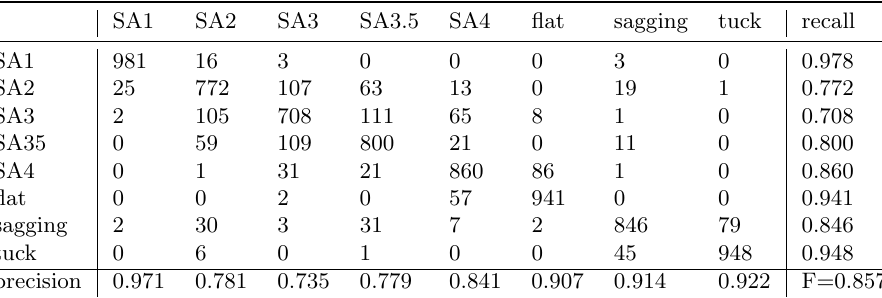
Table 5. Confusion matrix of detail class classi(cid:12)cation with selected